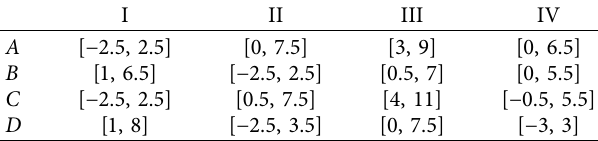
Table 15: Subtraction of the minimum interval in each column.